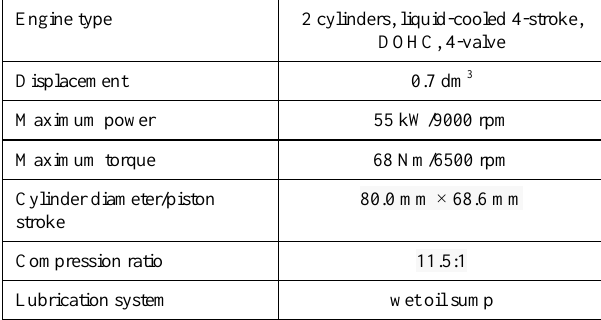
Table 1. Test motorcycle operating